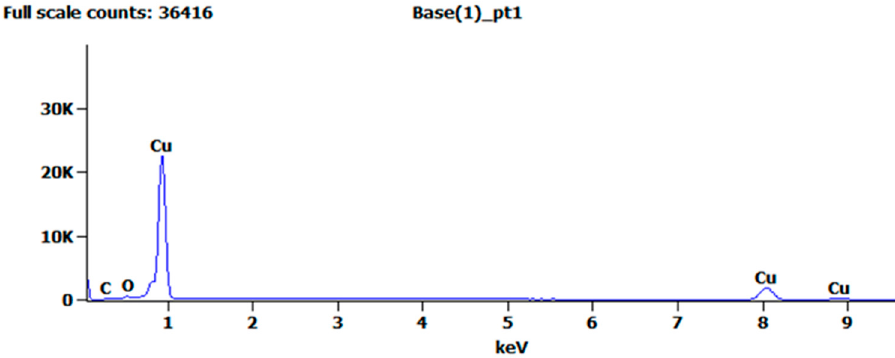
Figure 4. EDS analysis of the specimen after chemical corrosion. Table 1. Elemental composition and content of the microstructure. Element.